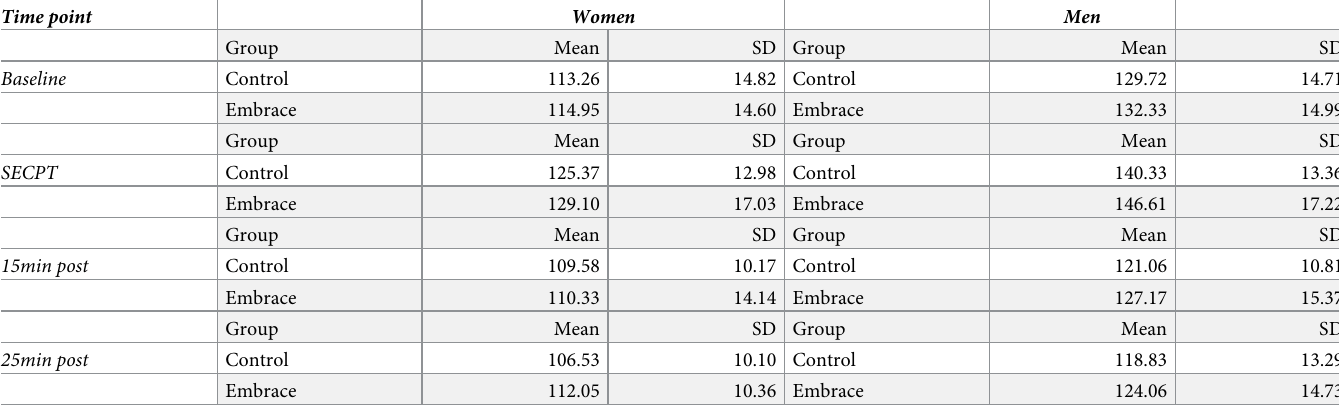
Table 2. Descriptive values (mean value and standard deviation) of systolic blood pressure values across the four measurement time points broken down by condi- tion and sex. Time